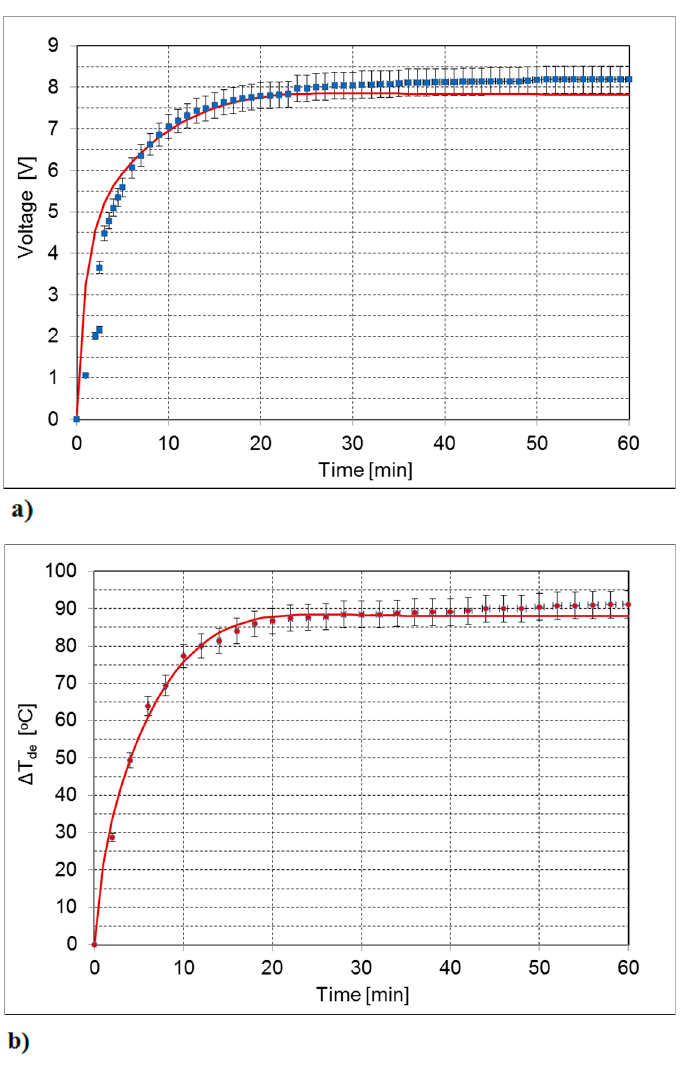
Figure 9. Transient simulation of ( a ) voltage supplied to fan ( b ) temperature difference between device and ambient temperature ( Δ T de ) for Qin = 120 W in Case A.